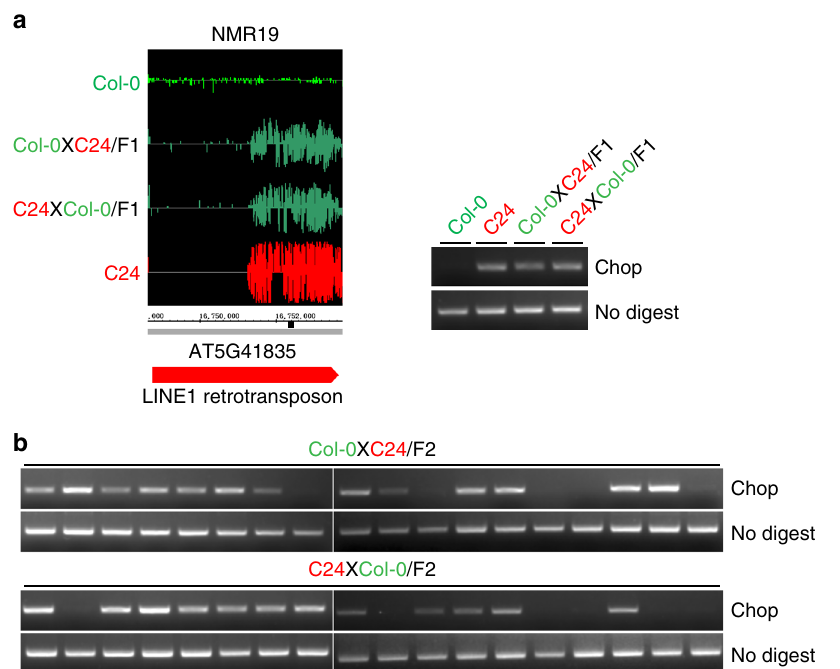
Fig. 1 Characterization of naturally occurring DNA methylation variation region 19 (NMR19) in Col-0 and C24. a Integrated Genome Browser (IGB) snapshot (left) showing methylation variation between Col-0, C24 and its F1 hybrids (Col-0XC24/F1 and C24XCol-0/F1) generated from BS-seq data. Black bar below the IGB snapshot indicates the site of restriction enzyme used for DNA methylation-sensitive PCR (Chop-PCR). Gel picture (right) depicts the validation of NMR19 methylation levels by using Chop-PCR. b Chop-PCR analysis of methylation patterns of NMR19 in F2 population from reciprocal crosses between Col-0 and